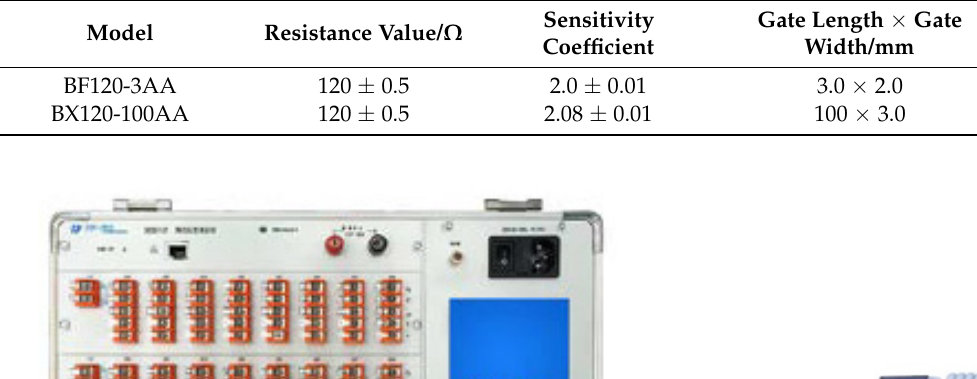
Figure 10. Location of test specimen displacement gauge.